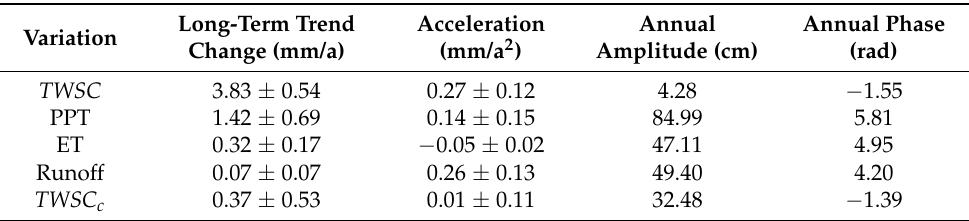
Table 5. The long-term change trend, acceleration, annual amplitude, and annual phase of TWSC and natural factors in Sichuan.